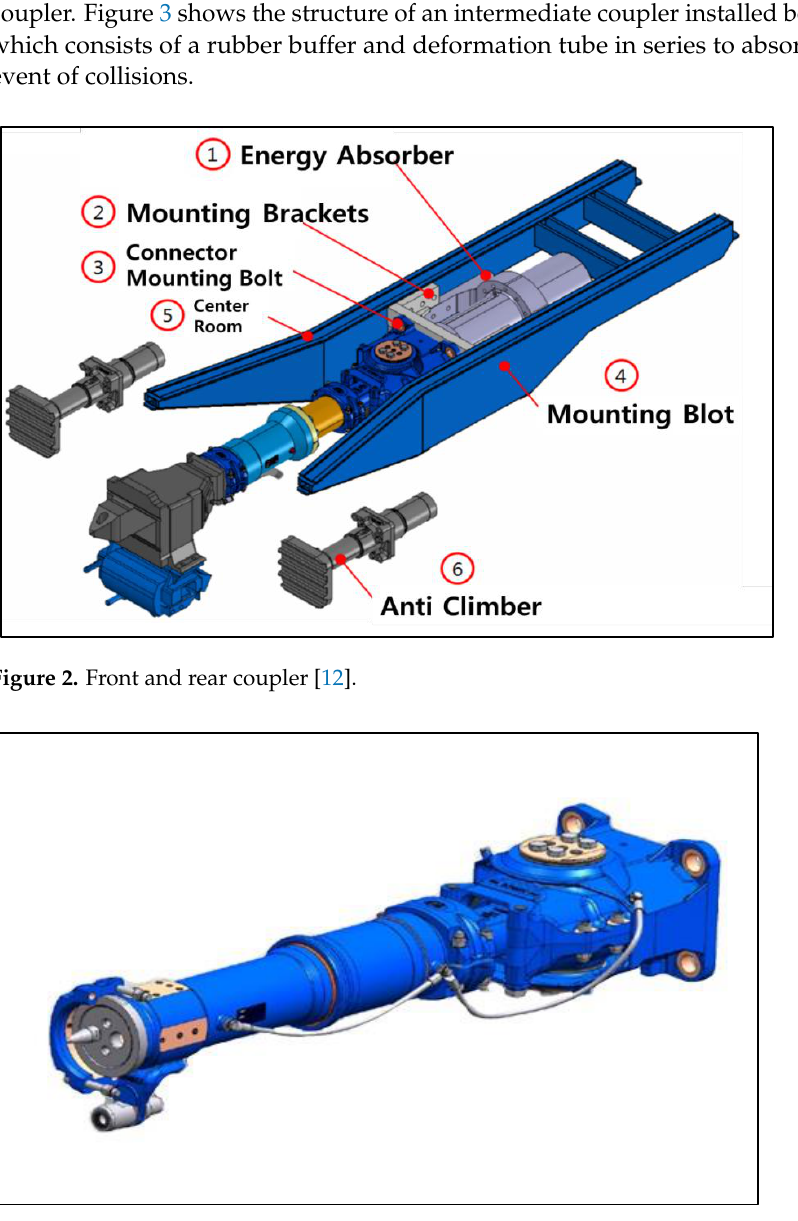
Figure 3. Intermediate coupler (rubber buffer and deformation tube) [12].